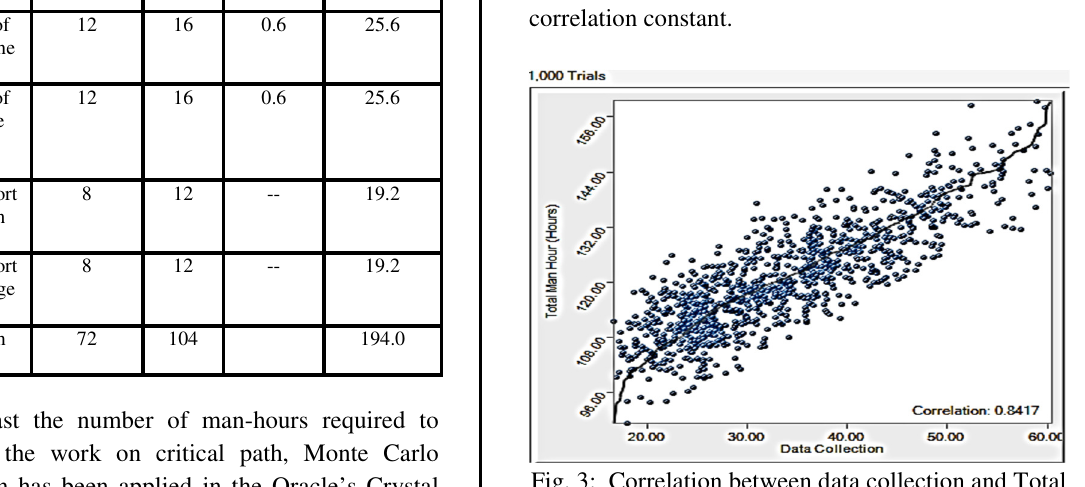
Fig. 3: Correlation between data collection and